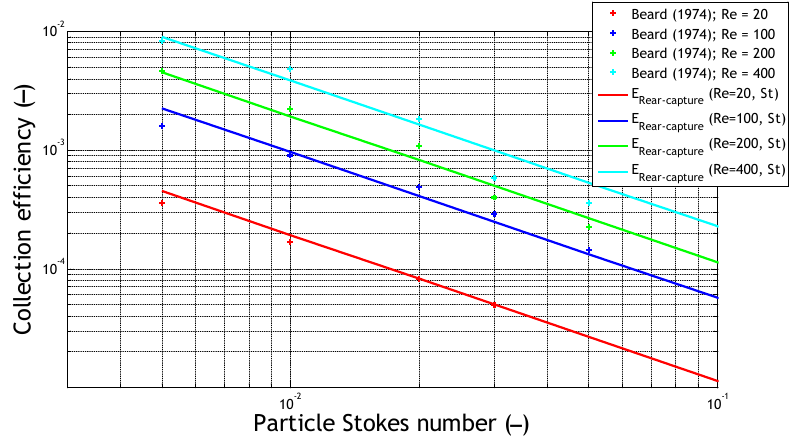
Figure 13. Semi-empirical parameterisation of rear capture.